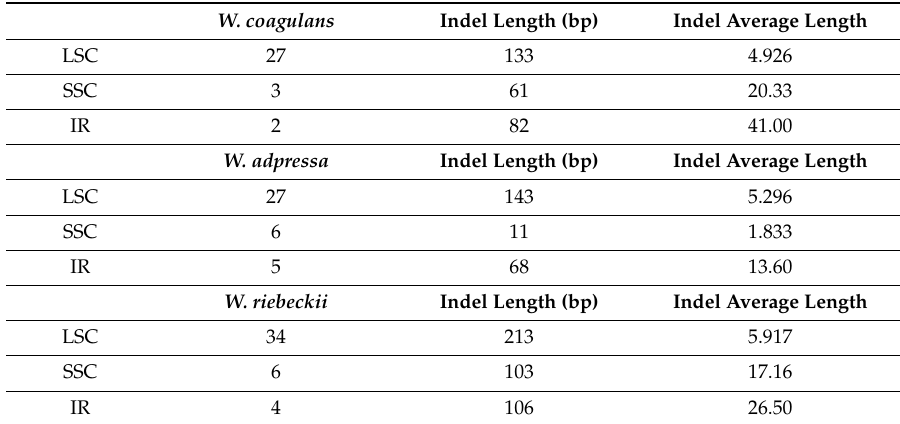
Table4. Insertionsand deletionsamong Withania speciescomparedto the W.somnifera reference genome. W.